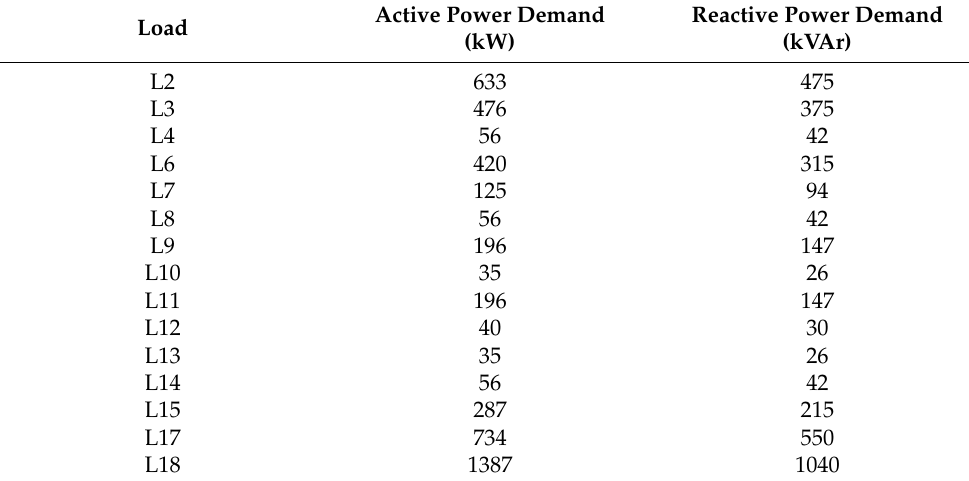
Table 2. Load data.